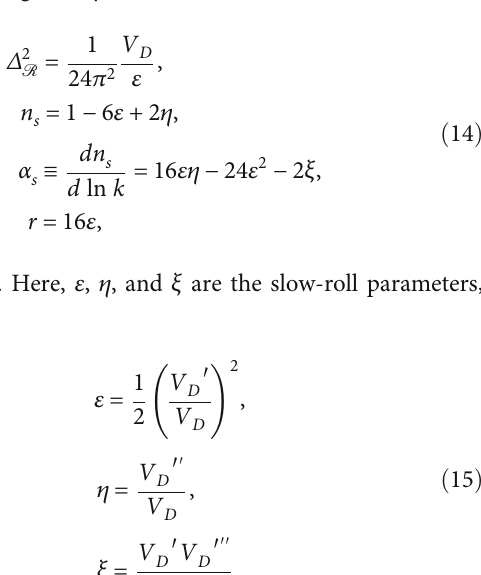
Figure 1: The D -term in fl ation potential for tan ð β Þ = 1 : 8 , g χ ≃ 1 : 9 , the potential along the Z direction stays nearly fl at implying in fl aton χ being much heavier than the Polonyi fi eld Z . For Z ≳ 1 , the e potential becomes very steep where slow-roll in fl ation cannot be